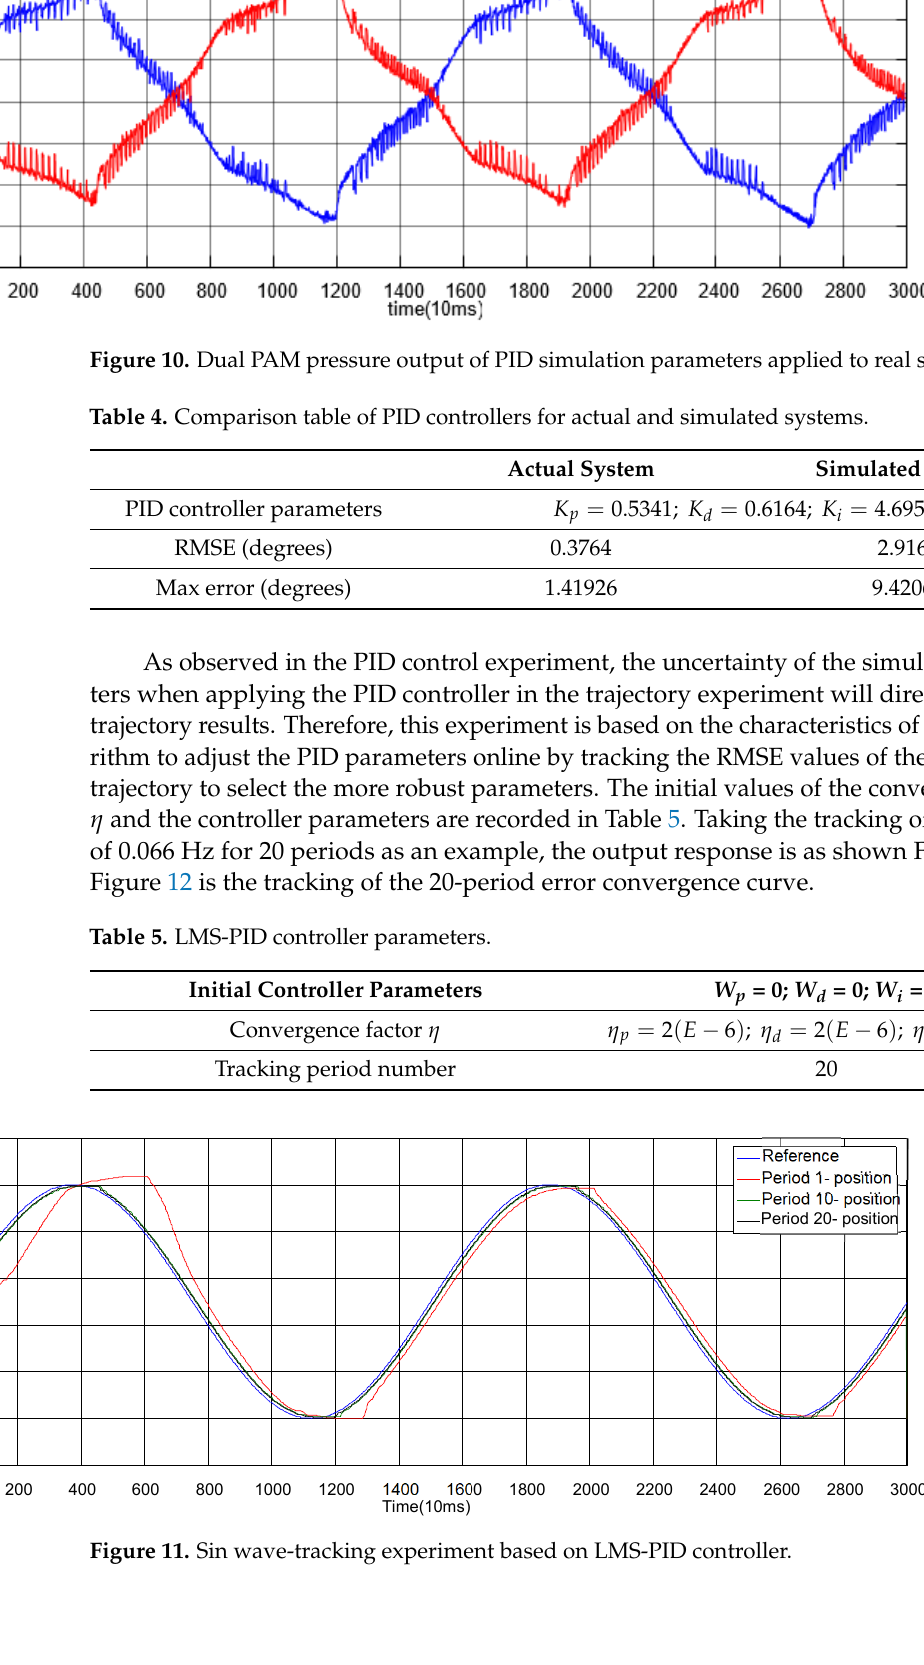
Figure 11. Sin wave-tracking experiment based on LMS-PID controller. Table 5. LMS-PID controller parameters.